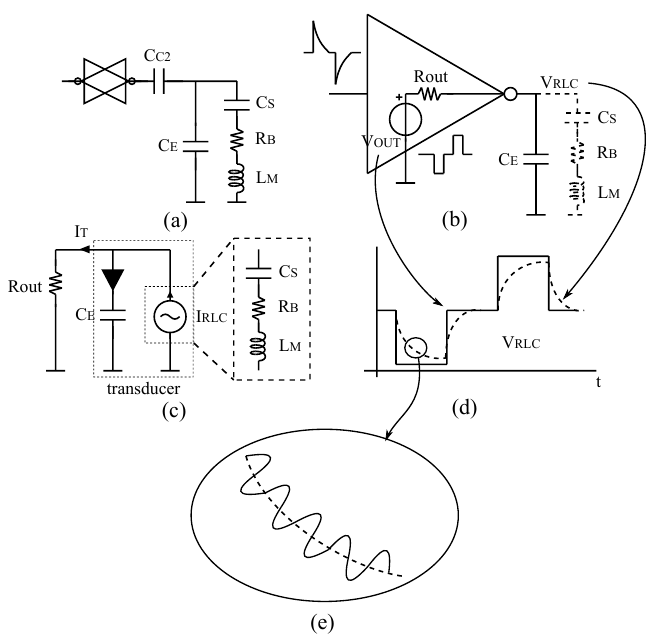
Figure 12. Analysis of the signal across the resonating sensor during the actuation mode. ( a ) sensor node analysis; ( b ) equivalent model for the amplifier during actuation mode neglecting the effects of the RLC series circuit; ( c ) modelling of the RLC circuit after actuation; ( d ) waveform analysis of the signal across the sensor neglecting the effect of the RLC circuit; ( e ) oscillation generated by the RLC circuit after